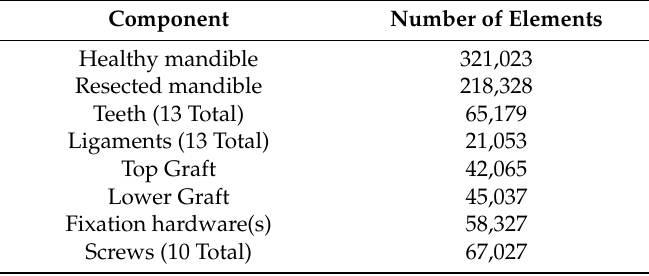
Table 1. The number of elements for the Finite Element Analysis model components. The number of tetrahedral elements was determined by convergence